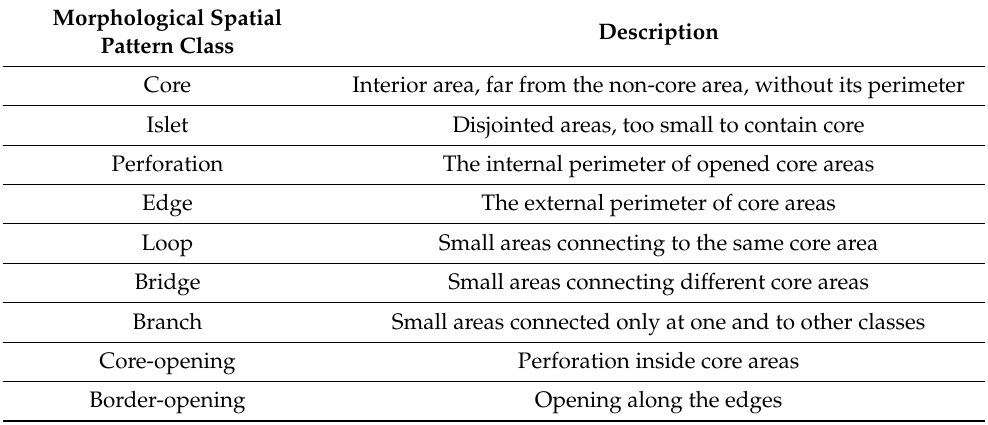
Table 2. Main morphological spatial classes analysed and their short description [53,62]. Morphological Spatial Description Pattern Class Core Interior area, far from the non-core area, without its perimeter Islet Disjointed areas, too small to contain core Perforation The internal perimeter of opened core areas Edge The external perimeter of core areas Loop Small areas connecting to the same core area Bridge Small areas connecting different core areas Branch Small areas connected only at one and to other classes Core-opening Perforation inside core areas Border-opening Opening along the